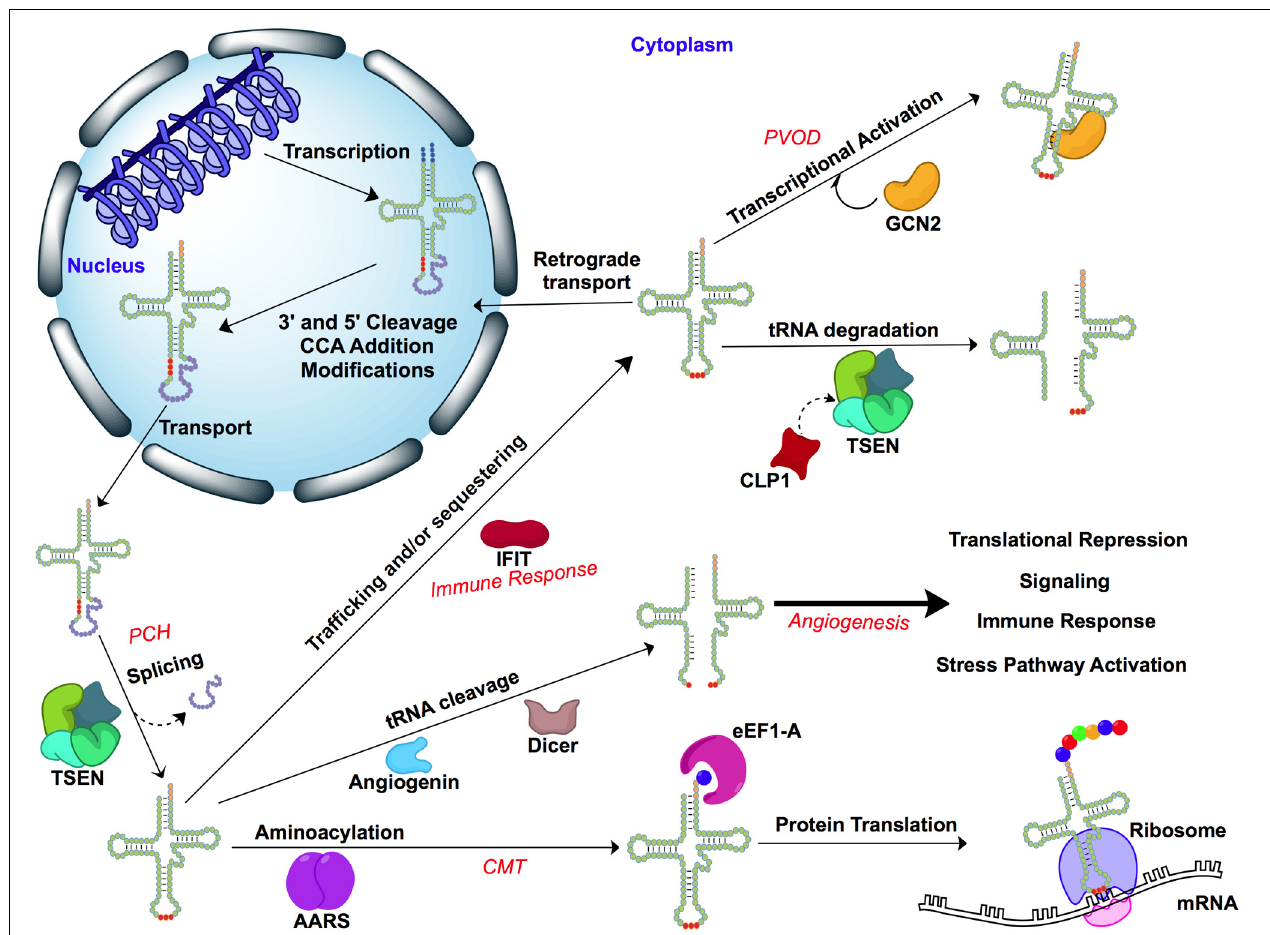
FIGURE 2 | Transfer RNA interactions and associated diseases. Cellular pathways of tRNA and interacting proteins and enzymes. Diseases discussed in this review are italicized in red. Figure was generated using BioDraw Ultra 12.0. Disease abbreviations: Charcot-Marie-Tooth disease (CMT), pulmonary veno-occlusive disease